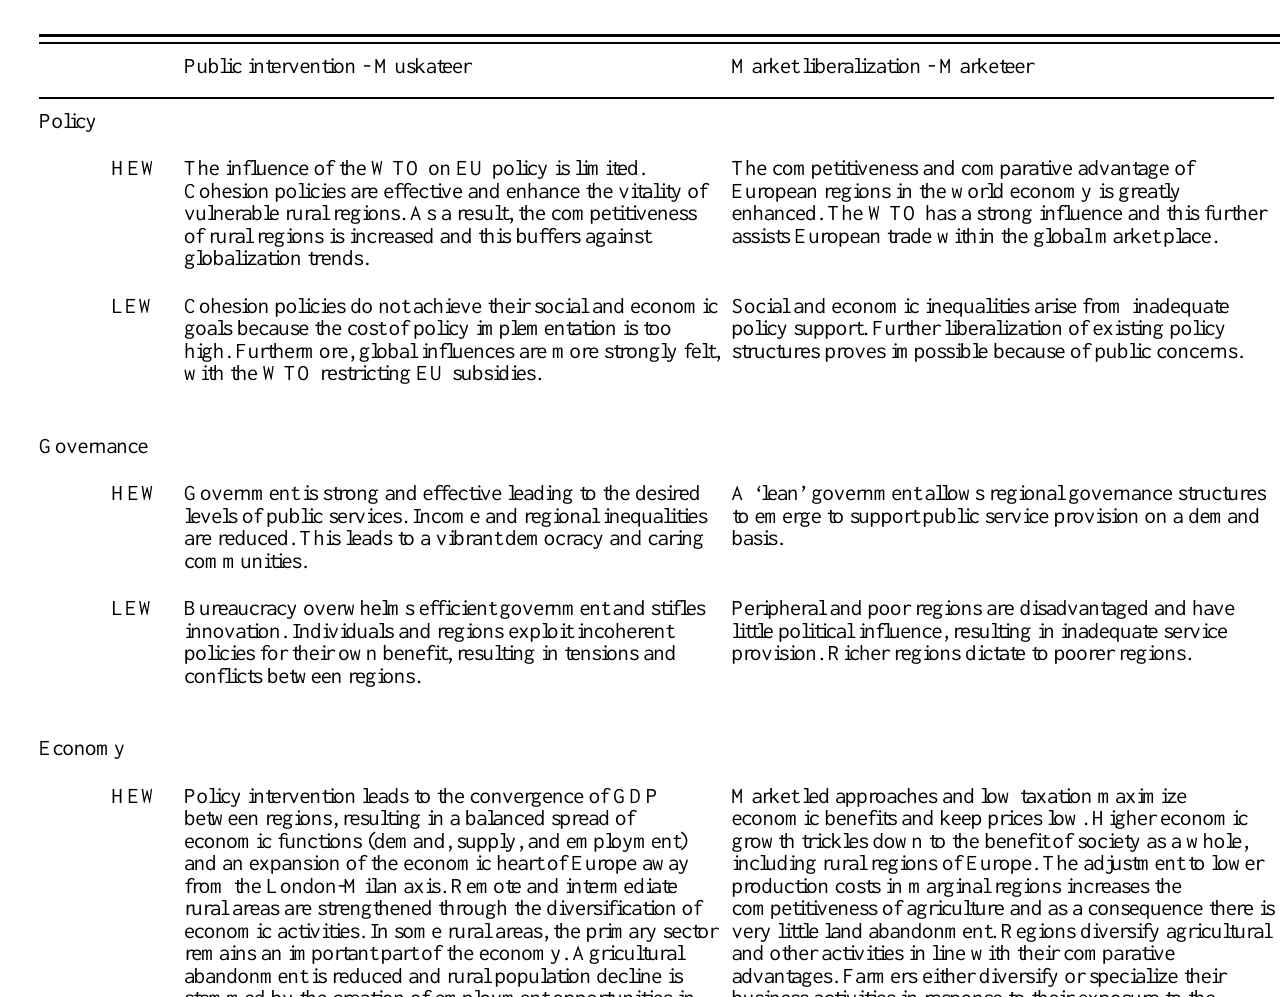
Table 5. High expectation world (HEW) and low expectation world (LEW) interpretations of the outcomes of the scenario principles (Table